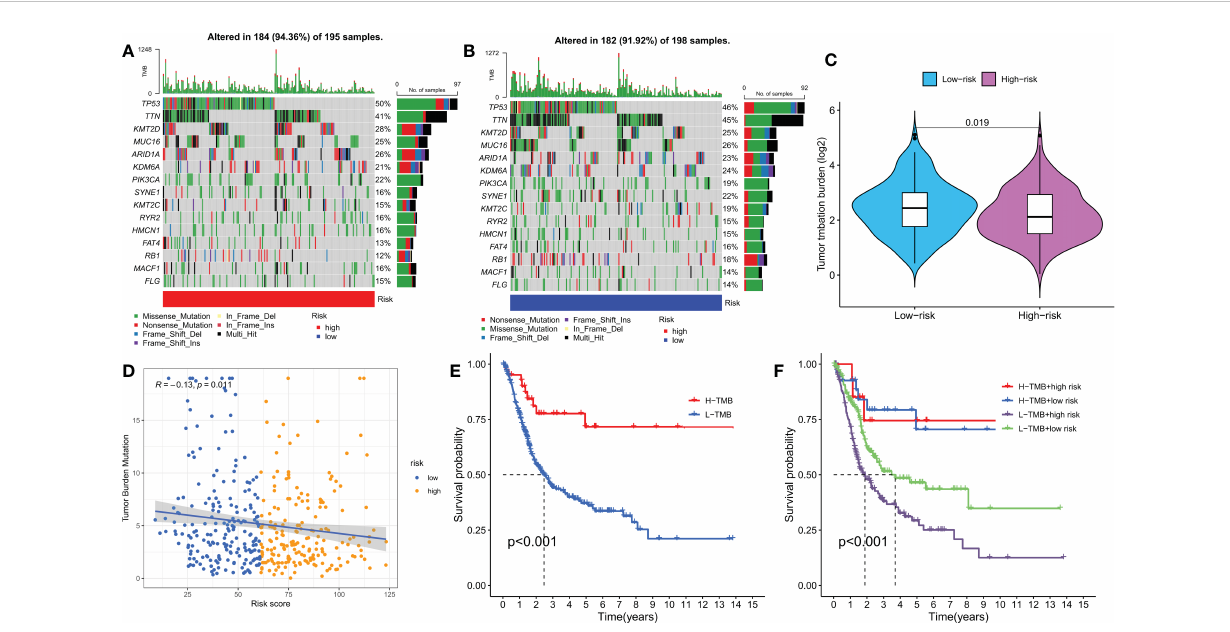
FIGURE 7 Mutation analysis based on the risk score model. (A, B) Waterfall plots summarizing the mutation status of high and low-risk patients. (C) The difference in tumor mutation burden between high and low-risk score groups. (D) Correlation between risk score and TMB. (E) Kaplan-Meier curves of high and low TMB groups. (F) Kaplan-Meier curves of four groups classi fi ed by risk score and